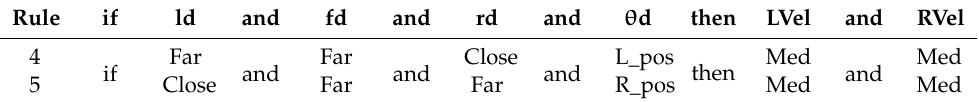
Table 3. Behavior rules for avoiding obstacles motion in navigation. Table 2. Behavior rules for following edge of obstacles motion in navigation.